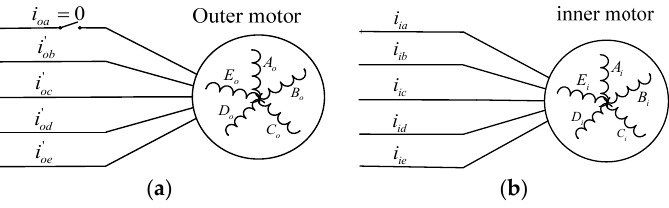
( b ) Figure 10. The back EMF waveform of ( a ) the outer motor and ( b ) the inner motor. From Table 5, we can see the large difference of the third harmonic component between the inner motor and outer motor. The third harmonic content of back EMF is 8.4% in the inner motor whereas